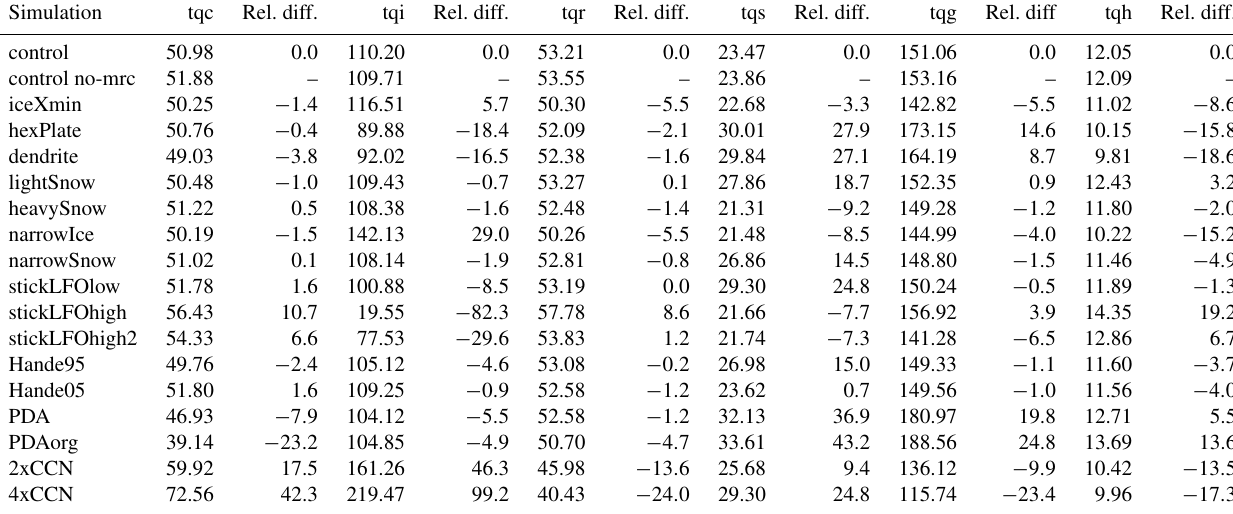
Table A2. List of all microphysical sensitivity studies including domain-averaged bulk quantities of column-integrated cloud variables (in gm − 2 ): cloud water (tqw), cloud ice (tqi), rain droplets (tqr), snow (tqs), graupel (tqg), and hail (tqh) as well as their relative difference (in %) to the ICON-LEM (DOM01) control simulation. All simulations in the microphysical studies were run with microphysics–radiation coupling turned on. “Control no-mrc” denotes a simulation in which this coupling was turned